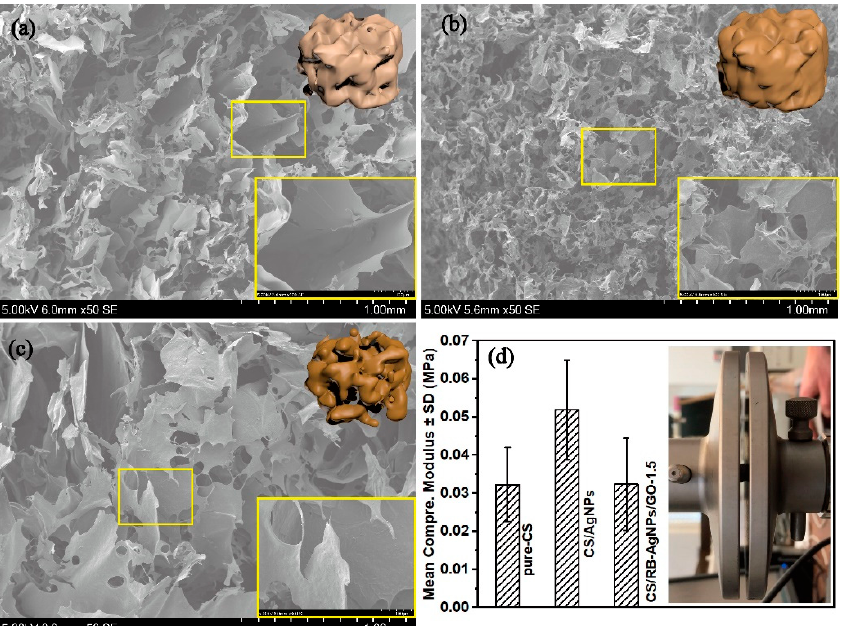
Figure 3. SEM images of ( a ) pure CS, ( b ) CS/AgNPs, and ( c ) CS/RB-AgNPs/GO-1.5. ( d ) Mean compressive elastic modulus of the nanocomposite samples ( n = 3 for each group).